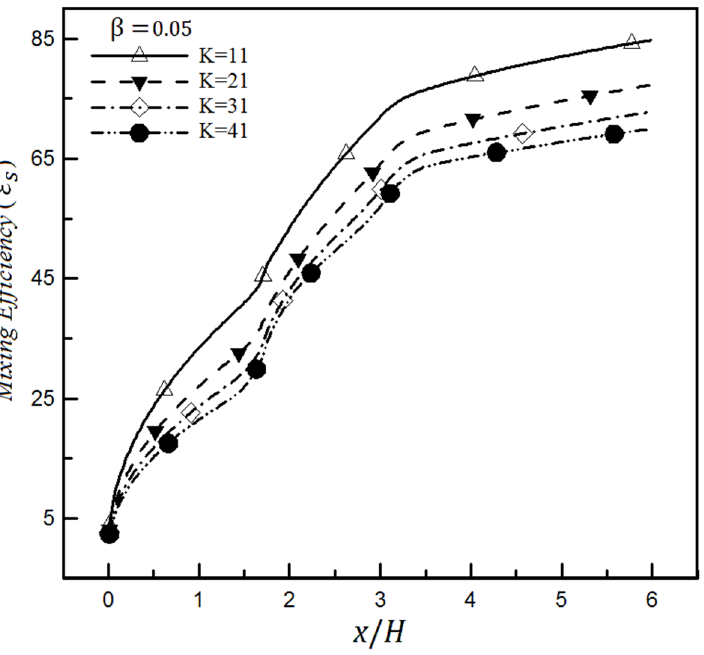
Figure 18. Mixing efficiency changes based on mixing entropy index in a heterogeneous microchannel for different Debye–Huckel values and a slip coefficient of 0.05.